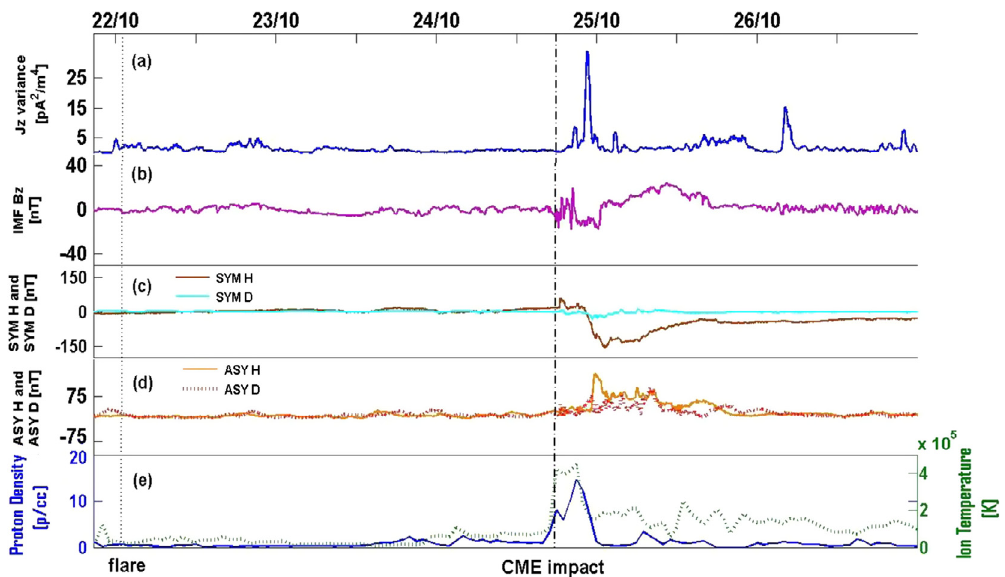
Figure 4. (a) J z fluctuations measured in MR during 22–27 of October 2011; (b) IMF B z ; (c) The horizontal symmetric geomagnetic disturbance field (SYM H, brown curve) and the orthogonal symmetric geomagnetic disturbance field (SYM D, turquoise curve); (d) The horizontal asymmetric geomagnetic disturbance field (ASY H, orange curve) and the orthogonal asymmetric (ASY D, red dotted curve); (e) ACE SW proton density (blue curve) and SW ion temperature (green dotted curve).